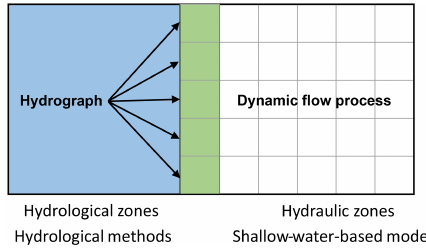
Figure 6. Divided study area of a coupled hydrological and hydro- dynamic urban surface